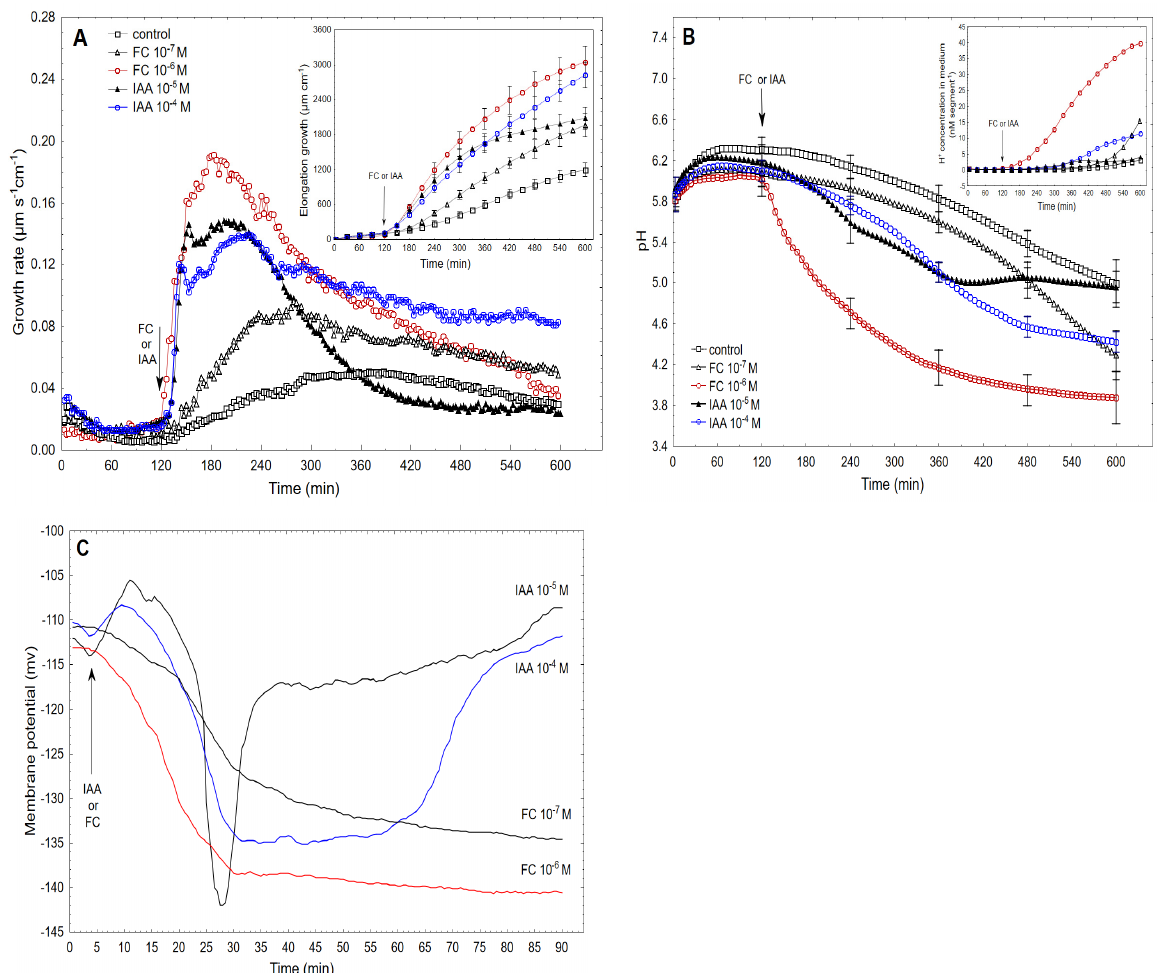
Figure 3. Kinetics of the FC- and IAA-induced growth rate ( A ), medium pH ( B ) and membrane potential ( C ) measured simultaneously at their optimal and suboptimal concentrations. The data for IAA-induced growth, proton extrusion and membrane potential changes was adopted from our recently published paper [8]. The growth rate ( µ m s − 1 cm − 1 ) of the maize coleoptile segments that had been incubated in the presence of the suboptimal (10 − 7 M) and optimal concentrations of FC (10 − 6 M, red curve) and both the suboptimal (10 − 5 M) and optimal (10 − 4 M, blue curve) concentrations of IAA are shown. The coleoptile segments were first preincubated (over 2 h) in the control medium to which FC or IAA was added (arrow). The insets show the total elongation growth ( µ m cm − 1 ), which was calculated as the sum of the extensions from 3 min interval measurements over 10 h (Figure 3A) and the proton extrusion is expressed as the changes in the H + concentration per coleoptile segment (Figure 3B). The medium pH changes were measured simultaneously with growth (Figure 3A) using the same tissue samples (red and blue curves as in Figure 3A). The membrane potential changes of the parenchymal coleoptile cells, which were simultaneously measured with the growth and medium pH changes and recorded at the suboptimal and optimal concentrations of FC and IAA are shown. All of the curves are the means of at least five independent experiments. Bars indicate ±